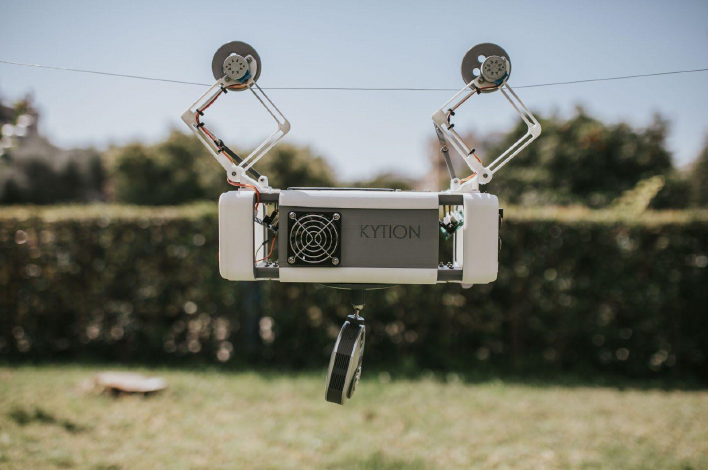
Figure 1. The KYTION